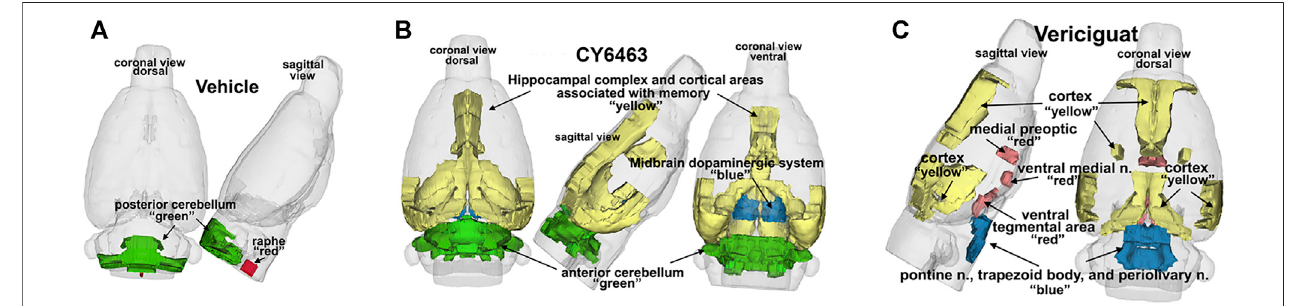
FIGURE 3 | 3D representation comparing CY6463 and vericiguat vs vehicle. (A) , positive BOLD activation for vehicle. (B) , positive BOLD activation for CY6463, hippocampal complex, and cortical areas associated with memory (yellow), anterior cerebellum (green), and midbrain dopaminergic system (blue). (C) , positive BOLD activation for vericiguat, cortex (yellow), medial preoptic, ventral medial nuclei and ventral tegmentum (red) pontine n, periolivary n, and trapezoid (blue) posterior cerebellum (green).